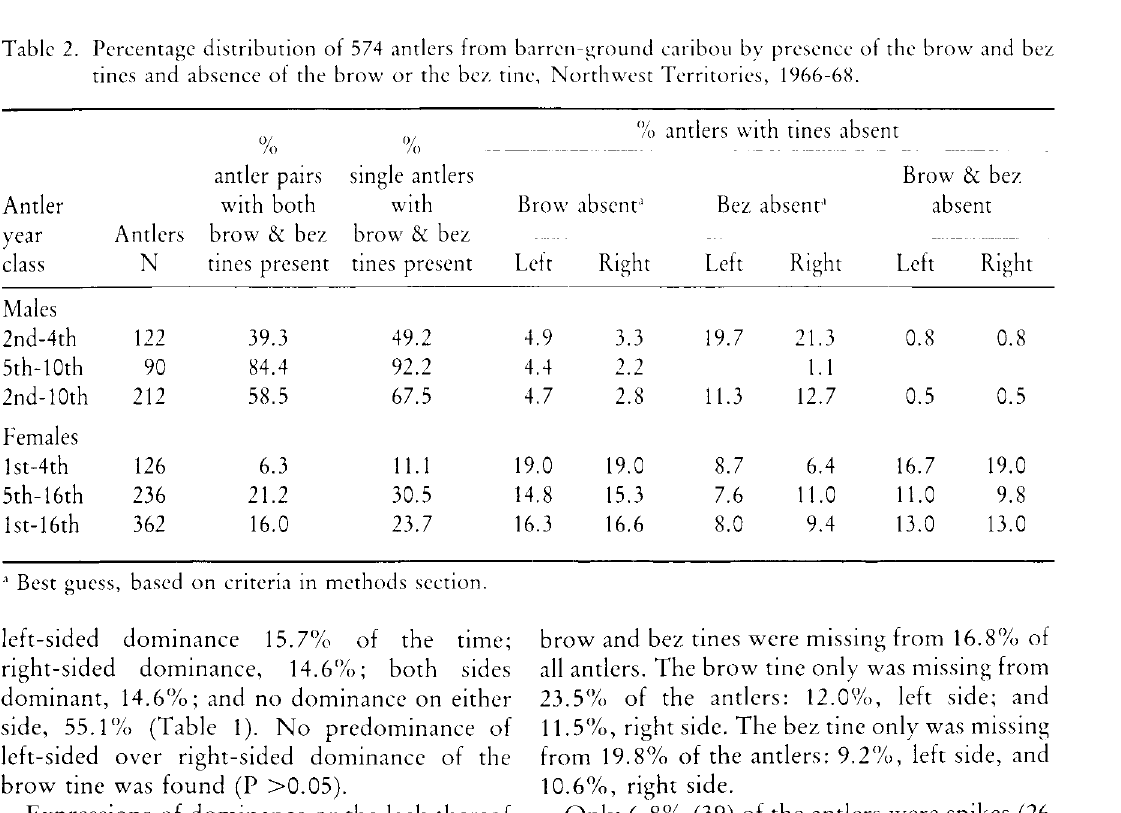
Table 3. Percentage distribution of 37 spike